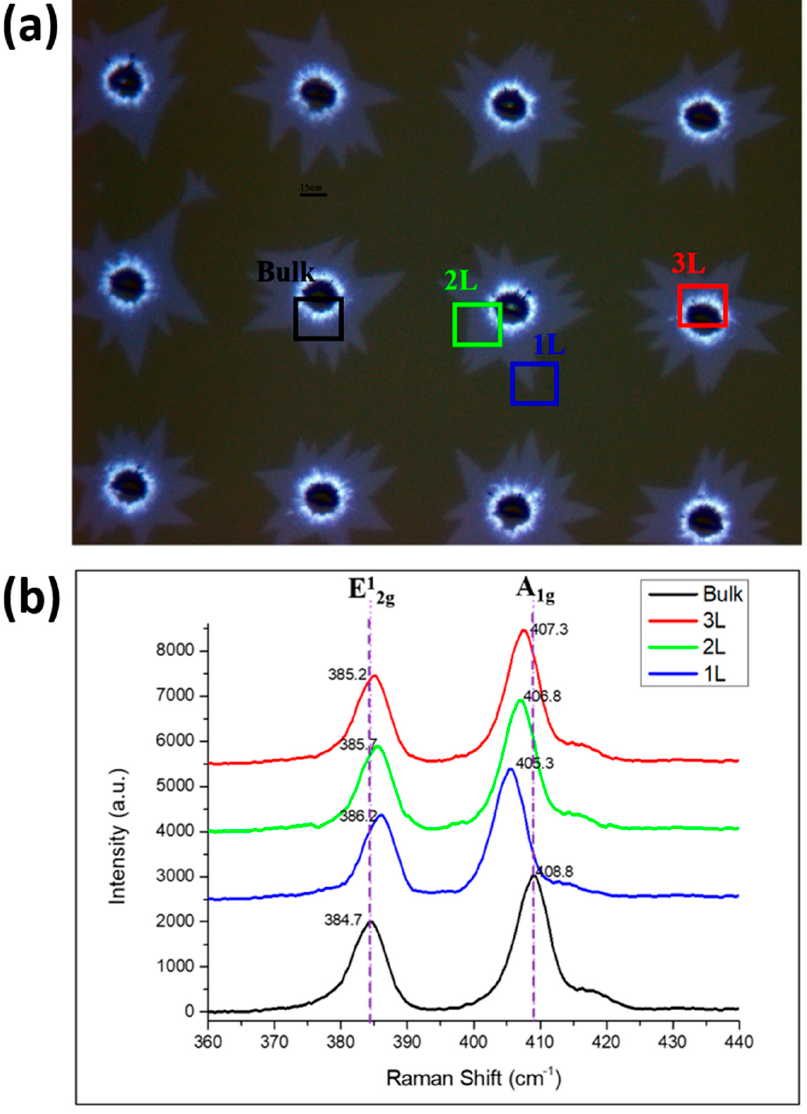
Figure 4. Panel ( a ) is an OM image of MoS 2 periodic growth, whereas ( b ) is the Raman measurement diagram of each area marked in ( a ).